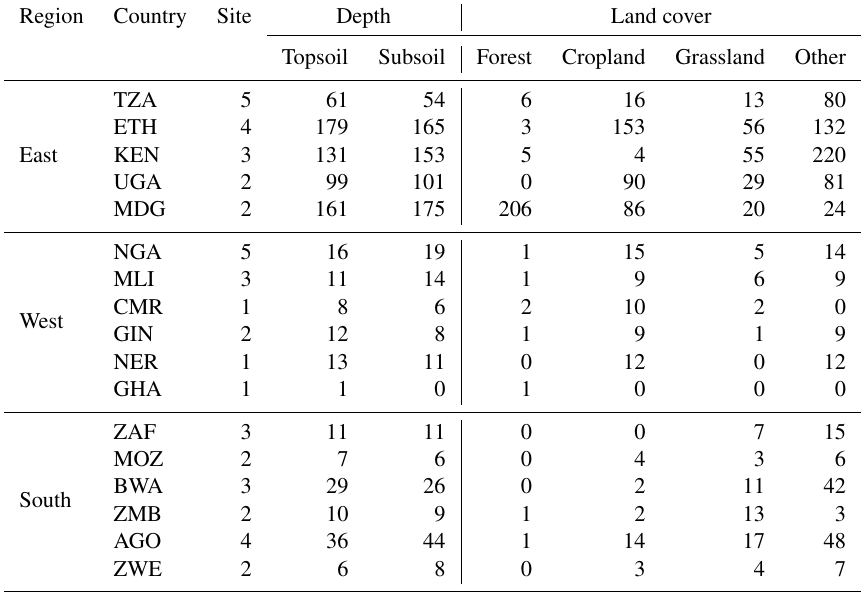
Table B1. Overview of sample distribution used in this study across geographical regions, countries, sites, depths and land cover.